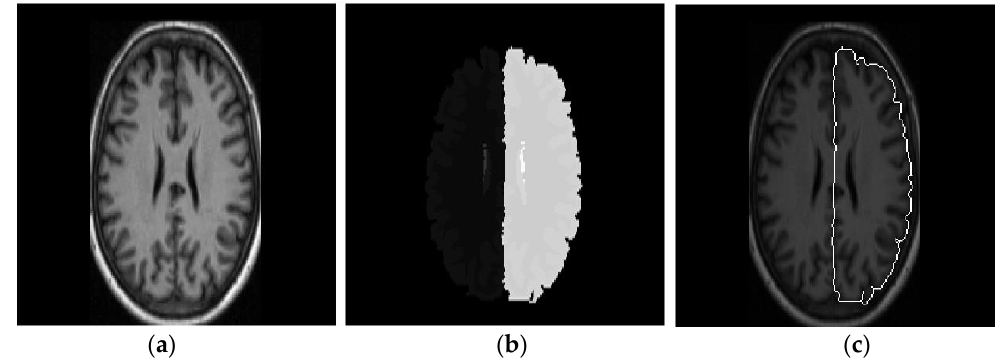
Figure 13. Superimposition of the ground truth (GT) image on the input image of the IBSR dataset [49]: ( a ) input image; ( b ) GT image; and ( c ) boundary of the right brain region is imposed on the input image with the white pixels.